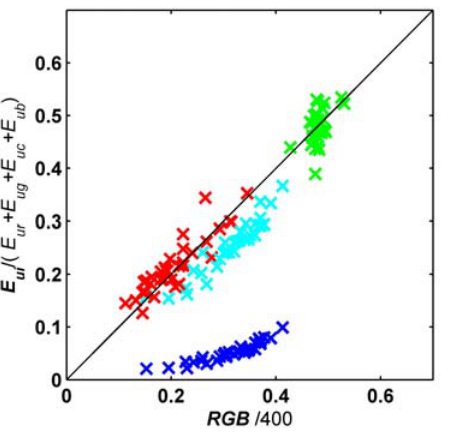
Figure 5. Scatter plot of OCS irradiance values in digital counts (DC), divided by total counts, against CP885’s RGB ( I = 400) values, obtained in situ in Galway Bay. The red tot marks indicate OCS red and CP885 red channel, the green marks OCS green and CP885 green channel, the cyan marks OCS cyan and CP885 blue channel, and the blue marks OCS blue and CP885 blue channel. The line shows a one-to-one